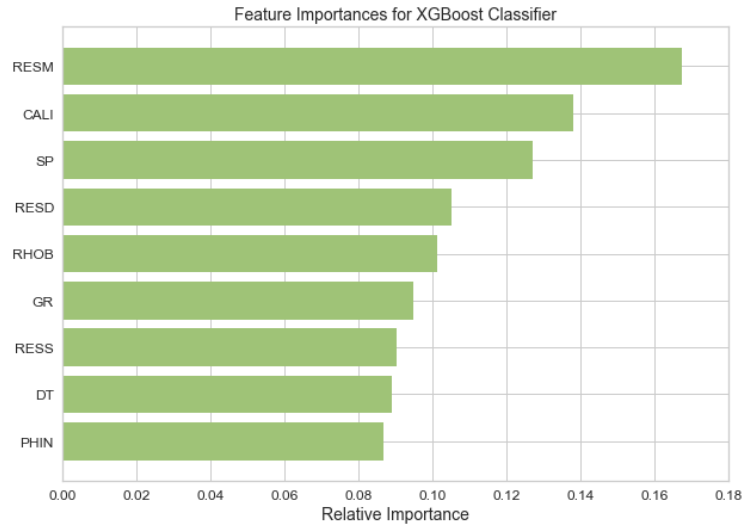
Figure 5. Feature importance of XGBoost model for each input well-logging